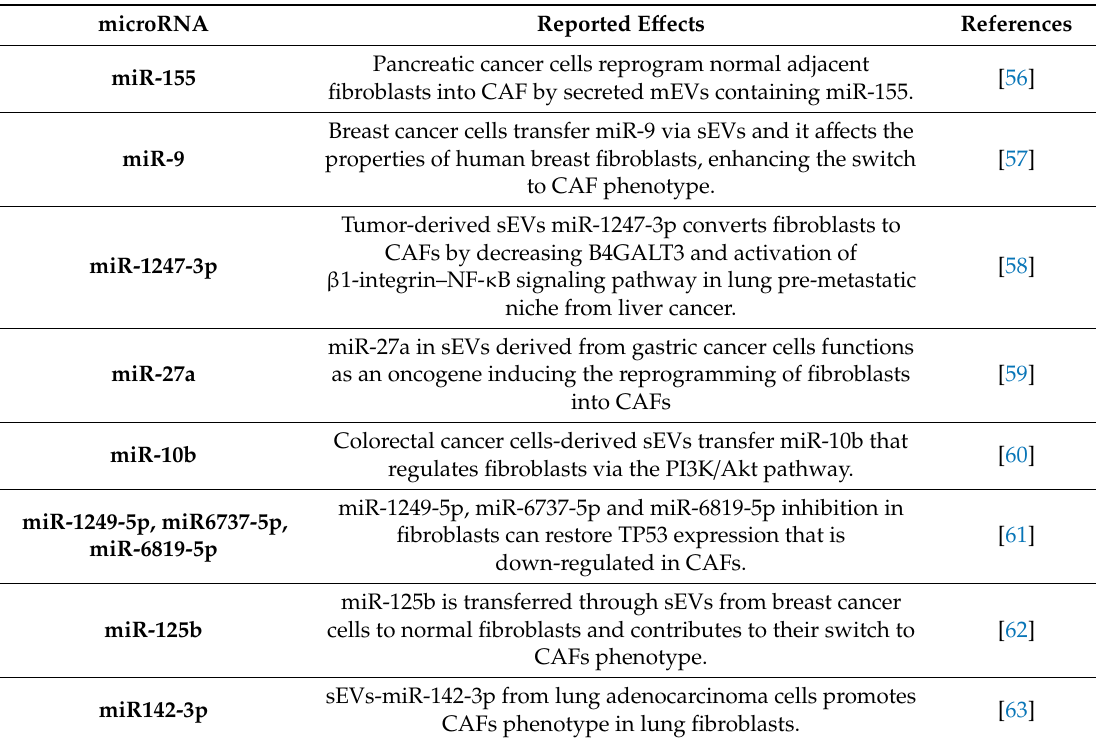
Table 2. Major microRNAs involved in fibroblasts conversion to